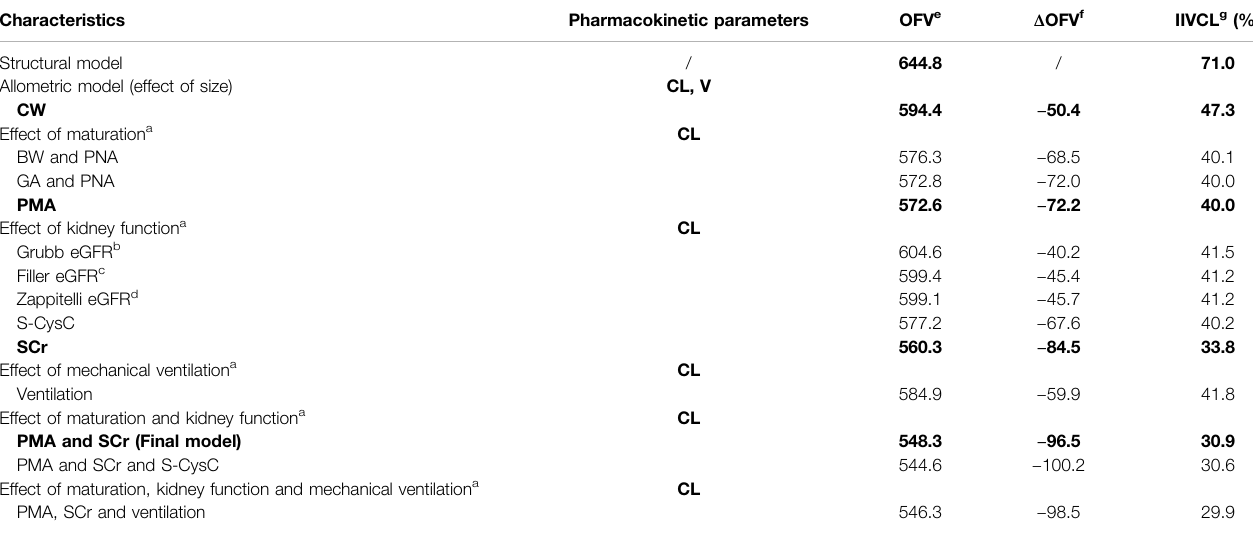
TABLE 2 | Summary of covariate analysis h . Characteristics Structural model